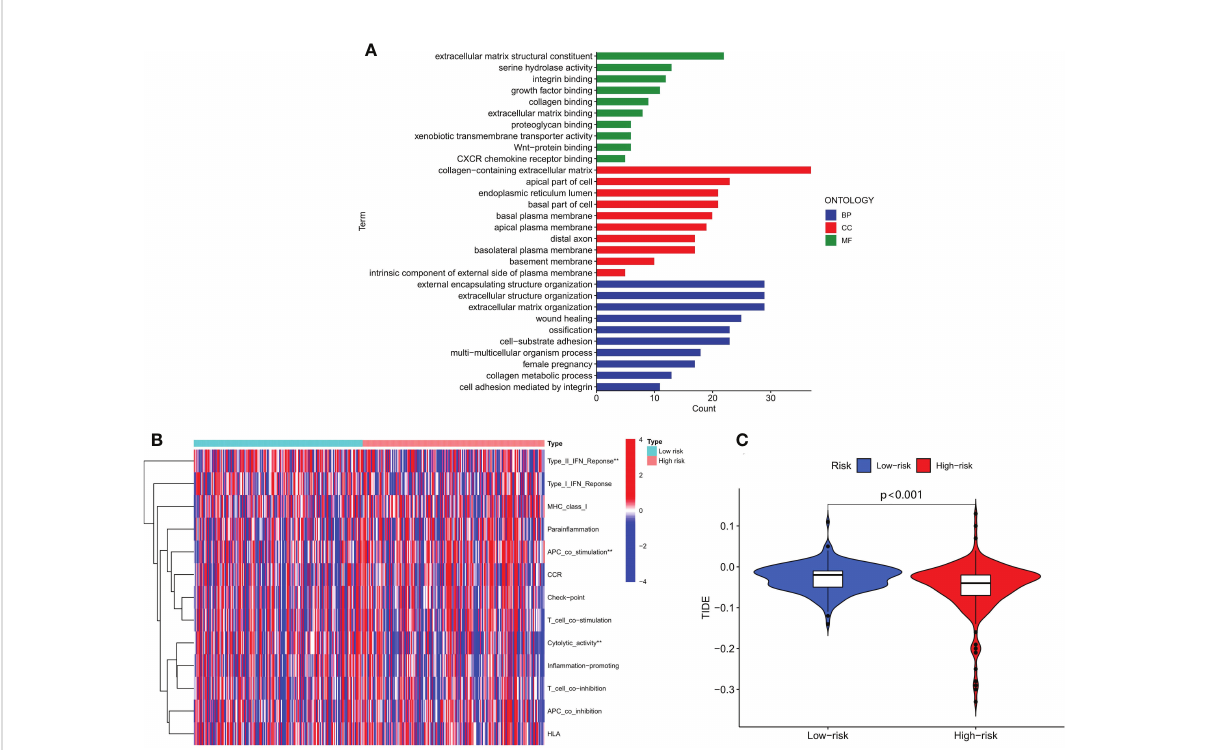
FIGURE 7 Functional analysis and estimation of immunotherapeutic response based on the m6A-associated snRNA model. (A) GO enrichment analysis based on the m6A-associated snRNA model. (B) Heatmap of the indicated standards of the immunity index based on the m6A-associated snRNA model. (C) TIDE scores in high- and low-risk HCC